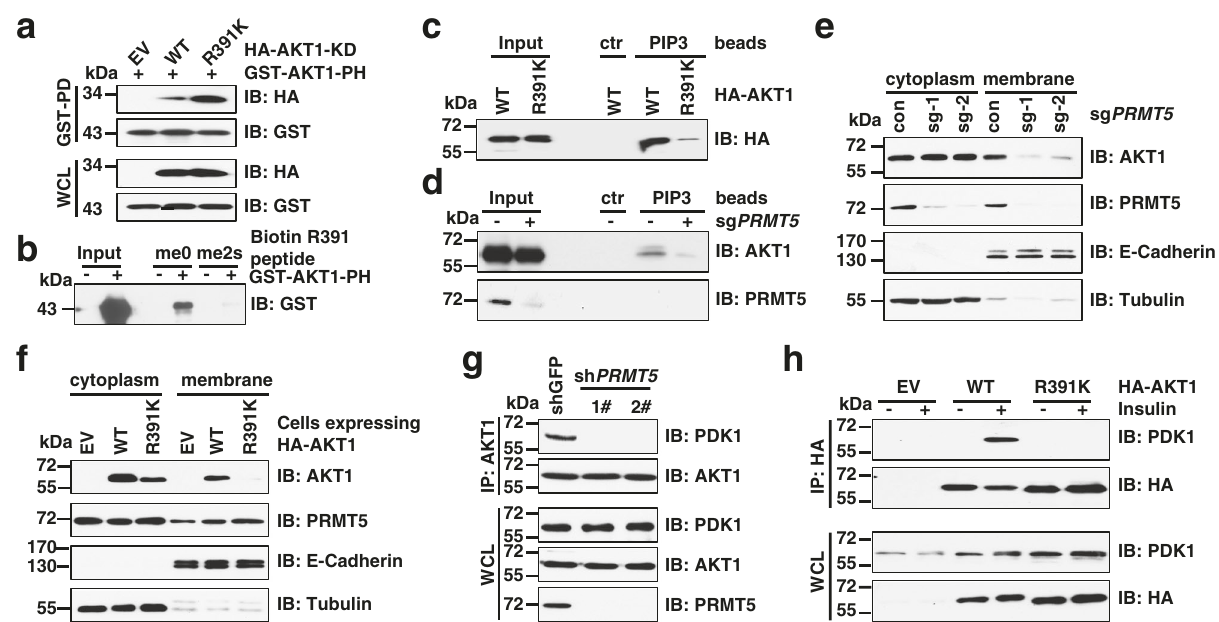
Fig. 5 AKT1-R391 methylation promotes AKT conformational change, membrane localization, and interaction with PDK1. a IB analysis of WCLs and GST pulldown products derived from HEK293 cells transfected with indicated constructs. b Biotin-conjugated R391 peptides with (me2s) or without (me0) dimethylation were incubated with recombinant GST-AKT1-PH and precipitated with streptavidin. Peptide (4 μ g) was used for each sample. c IB analyses of PIP3 pulldown products. HA-AKT1 proteins were puri fi ed from HEK293T cells transfected with HA-AKT1-WT or HA-AKT1-R391K. Empty beads (ctr) serve as a negative control. d IB analyses of PIP3 pulldown products and WCLs derived from PRMT5 -knockout MCF7 cells. e , f IB analysis of cell fractionations derived from PRMT5 -depleted MCF7 cells ( e ) or from DLD-1- AKT1/2 − / − cells expressing AKT1-WT or R391K mutant ( f ). g IB analysis